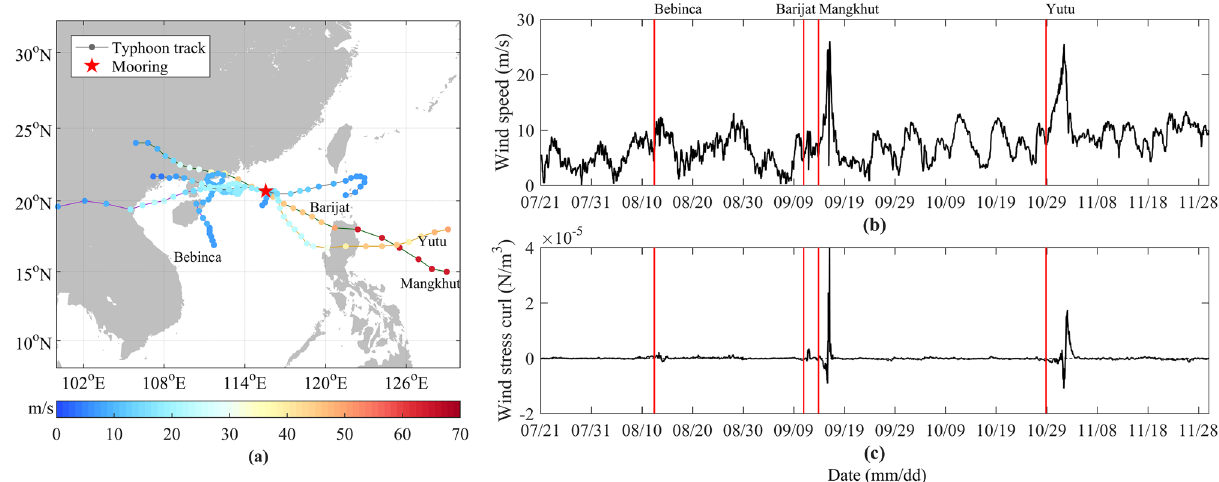
Figure 1. Map of the mooring near the Dongsha Islands in the SCS ( a ) and the time series of 10 m wind speed ( b ) and wind stress curl ( c ) over the sea surface at the mooring extracted from ERA5 data. The red pentagram denotes the mooring position. The solid lines with different colors denote the tracks of the four typhoons. The dots with different colors denote the maximum wind speed at the center of typhoons, and the unit of wind speed is m/s. The red vertical lines represent the time when typhoons passed. Figures are plotted using MATLAB R2016b (http:// www. mathw orks. com/).